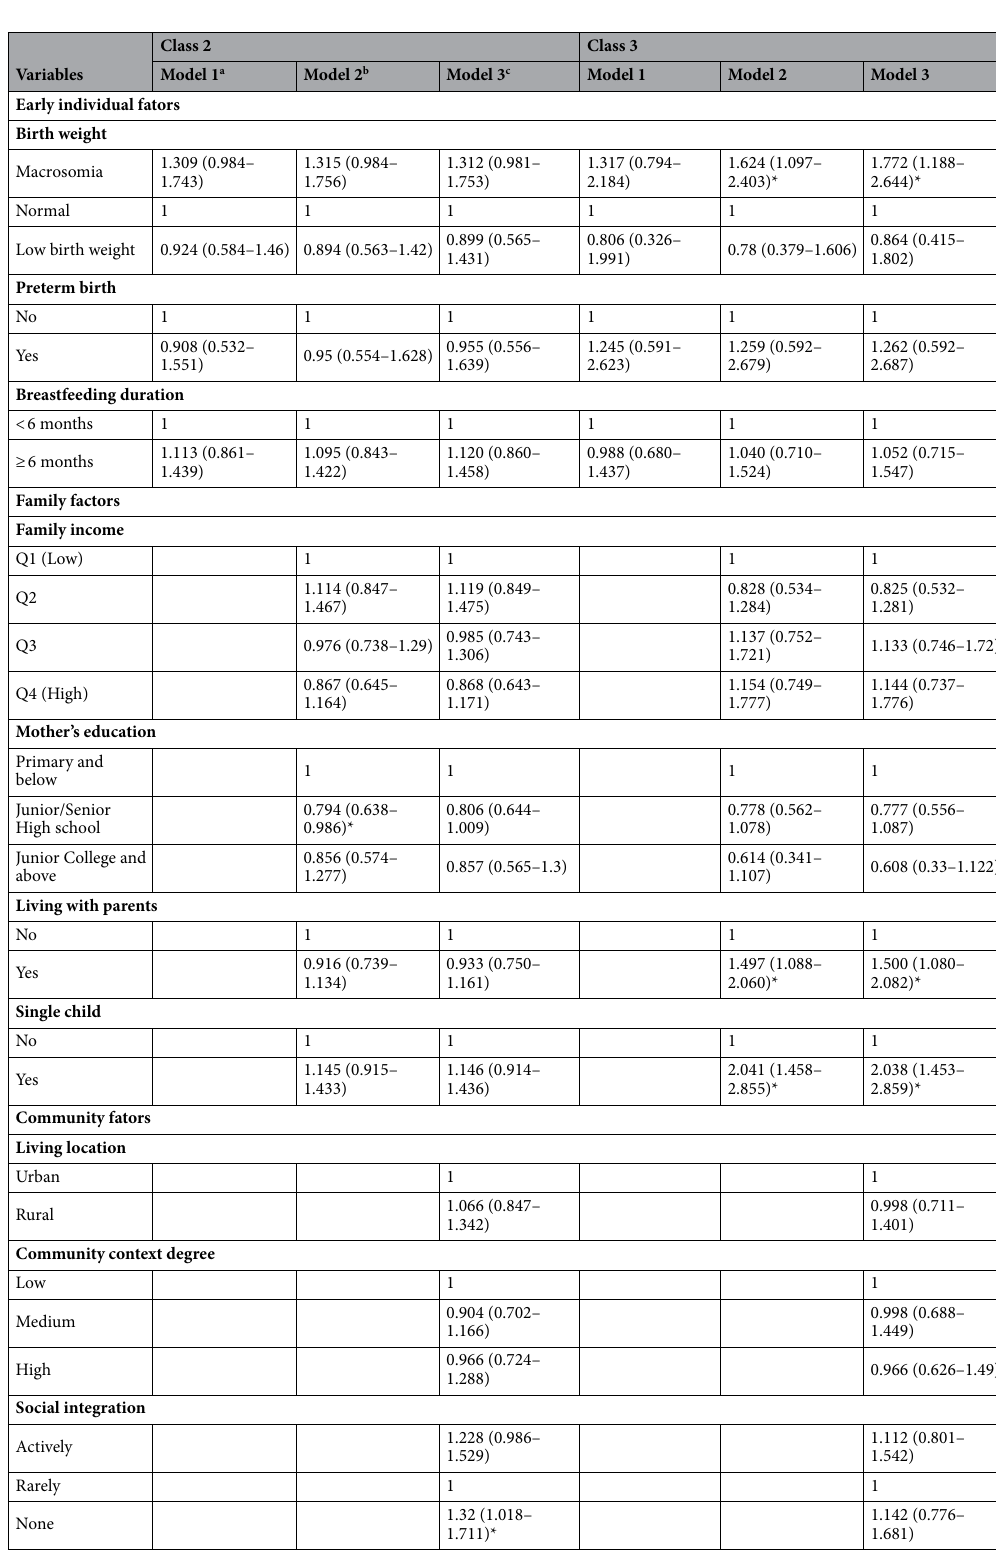
Table 5. Odds Ratios and 95% Confidence Intervals for early individual, family and community factors related to BMI z-scores trajectories membership among boys, CFPS. Class 1 was used as the reference